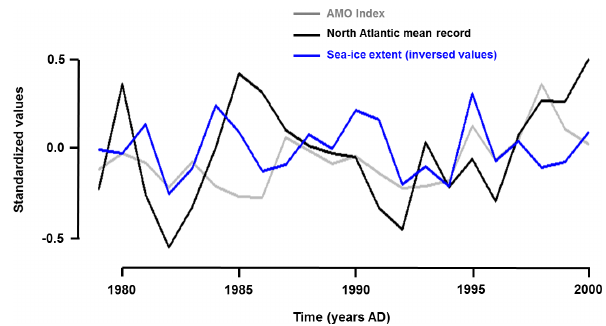
Figure 11. Comparison between the North Atlantic mean record based on proxy data, the AMO index and the global Arctic sea ice extent during their common period